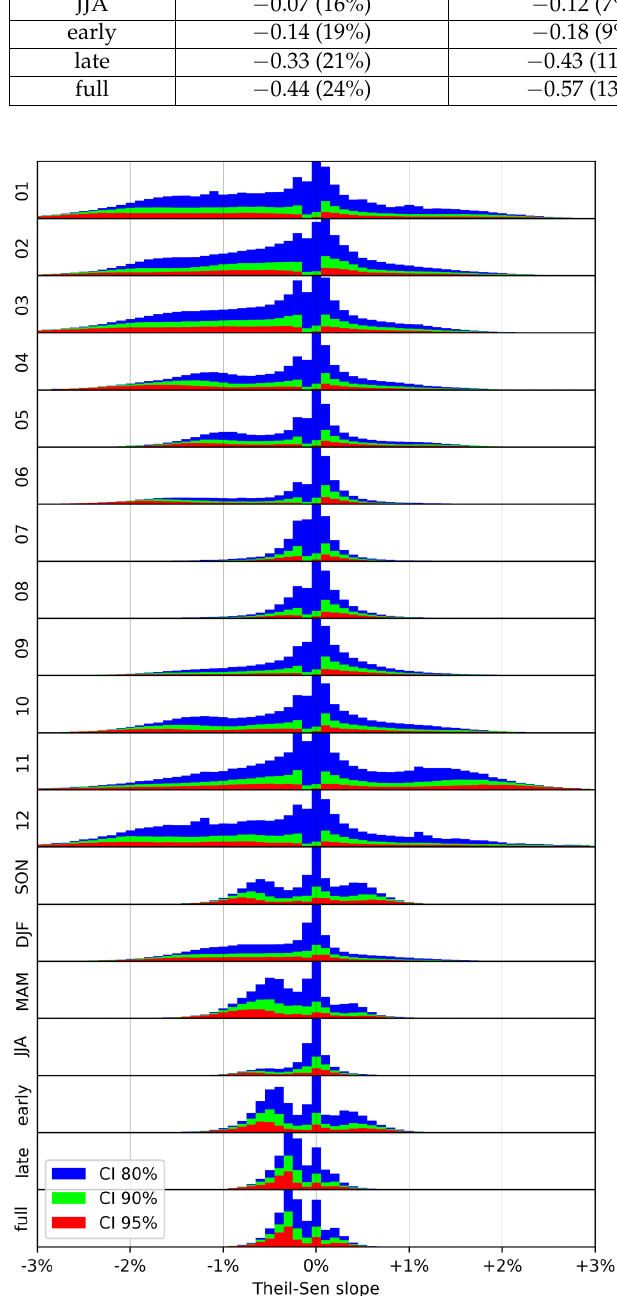
Figure A1. Histograms of derived Theil–Sen slopes of the pixel-based trend analysis of SCD for the 19 observed periods. The color coding represents the confidence intervals, and a normalization with the largest value was carried out.